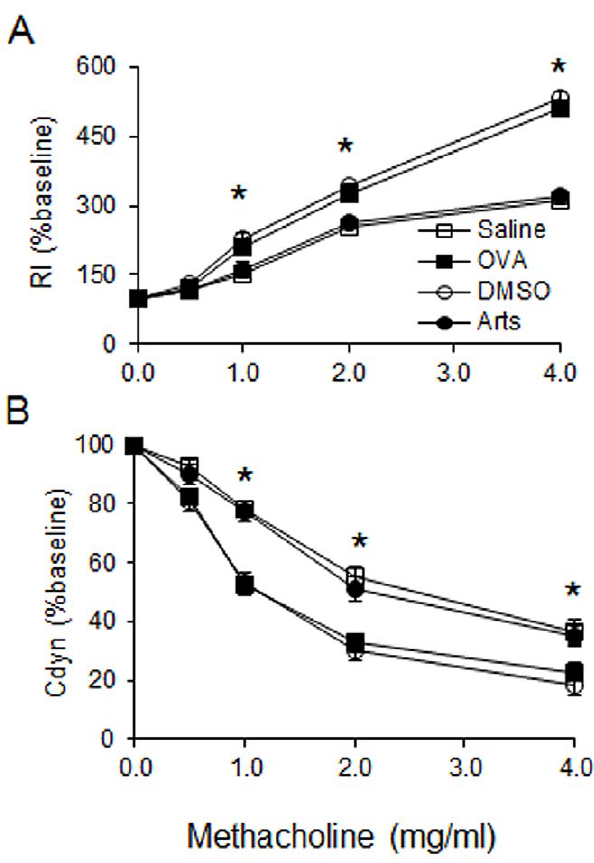
Figure 5. Effects of artesunate on OVA-induced inflammatory gene expression, PI3K/Akt activation and NF- k B DNA-binding activity in allergic airway inflammation. (A) Lung tissues were collected 24 hours after the last OVA aerosol challenge. Total mRNA was extracted using TriZol reagent and the quantitative real time PCR was performed. All reactions were run in triplicate and three independent experiments for each target. The relative quantity of target gene expression was automatically normalized by GADPH as an internal control and values shown were the ratios of various treatments to saline group. (B) Immunoblotting of Akt, tuberin, p70S6K and 4E-BP1 in protein extracts of lung tissues isolated from mice 24 hours after the last saline aerosol or OVA aerosol challenge pretreated with either DMSO or 30 mg/kg artesunate. b -actin was used as an internal control. The experiments were repeated for three times (n=3 mice) with similar pattern of results. (C) Nuclear p65 DNA-binding activity was determined using a TransAM TM p65 transcription factor ELISA kit. Values shown are the mean 6 SEM of four separate experiments. *Significant difference from DMSO control, p ,